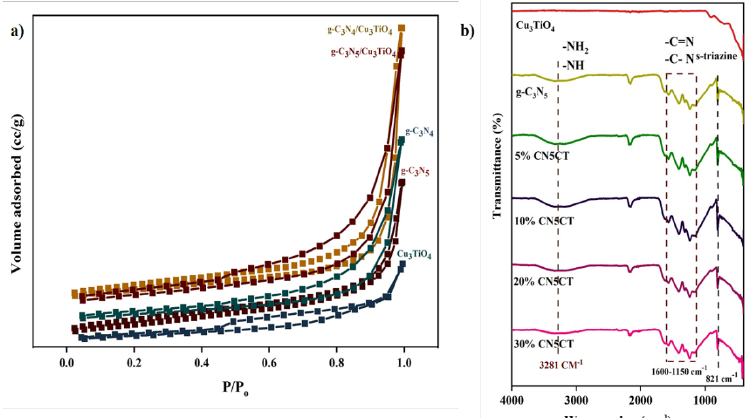
Figure 2. ( a ) BET isotherm and ( b ) FT-IR spectra. In XPS, the chemical state of the prepared 10% CN5CT was exposed in Figure S1. Figure S1a shows the survey spectrum of the synthesized 10% CN5CT nanocomposite and all the signals confirmed the presence of C, N, Cu, Ti, and O. For C 1s, in Figure S1b, the three strong peaks at ~287, 285.8 and 283 eV show the presence of C 1s in nanocomposite, which corresponds to N-C-N, C-N and C-C bonds [70]. Then N 1s displayed two peaks at 399 and 397 eV, providing evidence for the presence of N 1s species (Figure S1c) with different environments of N-C and C-N-C bonds [71]. Cu 2p exposed two major peaks at 953 and 933 eV (Figure S1d) combined with two satellite lines, confirming the presence of Cu 2p species in the CN5CT composite [72]. The two peaks (Figure S1e) at 462 and 456 eV confirm the presence of Ti 2p species in CN5CT nanocomposite [72]. Finally, for O1s spe- cies, two strong peaks (Figure S1f) at 529 and 531 eV confirmed the existence of oxygen- metal and oxygen-hydrogen bonds in the composite. The typical morphology of the g-C 3 N 5 and g-C 3 N 5 /Cu 3 TiO 4 nanocomposite is shown in Figure 3a,b, indicating that the prepared g-C 3 N 5 has a sheet-like morphology. As seen in Figure 3a, exfoliation caused the evolution of 3-amino-1,2,4-triazole into a typical lay- ered structure, showing the formation of a loosely packed 2D g-C 3 N 5 structure. In Figure 3b, 10%CN5CT nanocomposite, and Cu 3 TiO 4 nanoparticles are marked. The 10% CN5CT nanocomposites showed a strong connection between g-C 3 N 5 and Cu 3 TiO 4 , indicating that there would be a physical adsorption. It also implied that g-C 3 N 5 might prevent the ag- gregation of Cu 3 TiO 4 NPs as compared to Figure 3b. The effectiveness of the electron-hole separation can be increased by closing interfacial contacts between g-C 3 N 4 and Cu 3 TiO 4 nanoparticles by excellent dispersion. According to the elemental mapping in Figure 3c– f, the elements C, N, Ti, Cu, and O were evenly distributed throughout the 2D layered and 3D nanoparticle structures.